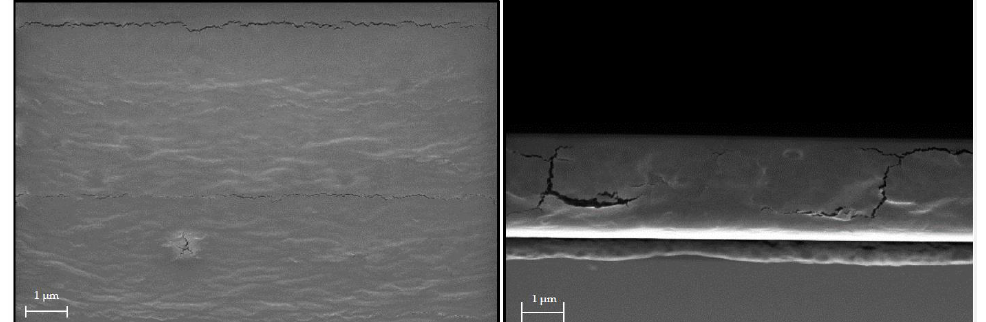
Figure 2. SEM images of the ProMa coating on a silica wafer (2 cm × 2 cm) from the profile and surface view; samples were coated with ProMa and dried for 2 h by 80 °C (surface gold sputtered).